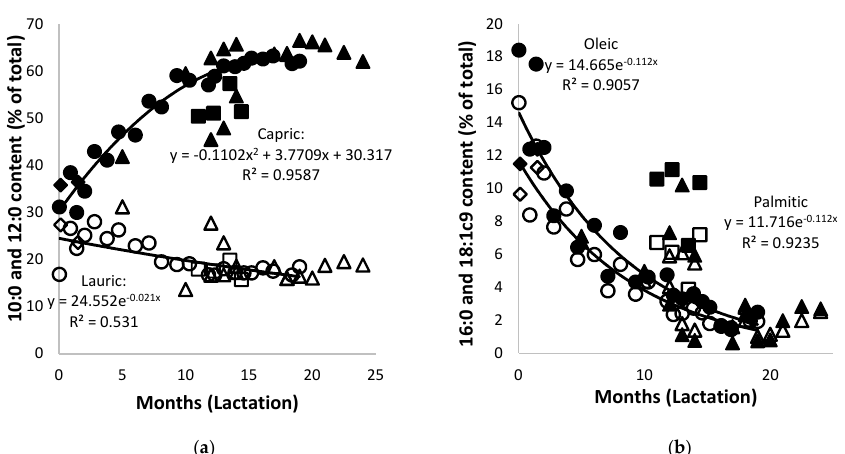
Figure 5. ( a ) Changes of capric (solid symbols) and lauric acids (open symbols) and ( b ) of palmitic (solid symbols) and oleic acids (open symbols) in milk of African elephants during lactation (Shorty ( • ◦ ), Bloem ( ♦ ◊ ) Mussina ( ■ □ ), and others ( ▲ Δ )). Trend lines for combined data of all elephants were y = − 0.0617x 2 + 2.802x + 32.557 and R 2 = 0.9421 for C10:0, y = 0.0203x 2 − 0.8453x + 26.226 and R 2 = 0.4451 for C12:0, y = 0.0211x 2 − 0.9033x + 11.591 and R 2 = 0.7818 for 16:0, and y = 0.0217x 2 − 1.018x + 13.997 and R 2 = 0.6586 for C18:1c9.